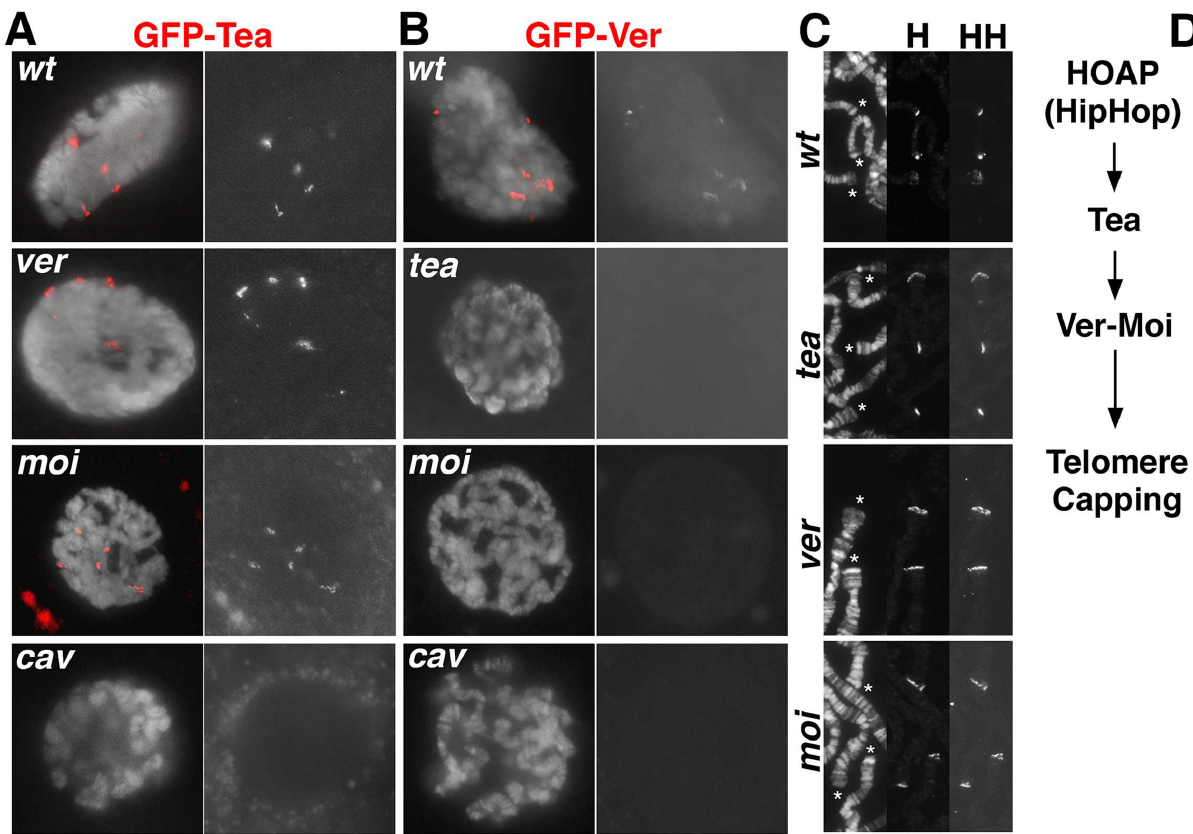
Fig 2. Genetic control of capping protein localization on polytene chromosomes. The localization of GFP-Tea ( A ) and GFP-Ver ( B ) under different genetic backgrounds was monitored as live GFP fluorescence.At least 50 nuclei were examinedfor each genotype and all nuclei showed a “present” or “absent” pattern of GFP fluorescence similar to the ones chosen for the Figure. The localizationof HOAP and HipHop under similar genetic backgrounds was monitored by antibody staining ( C ). For A and B , genotypes are indicatedat the top left of the images. For C , genotypesare indicatedto the left of the images. In A and B , the left panel displaysmerged images of GFP signal in red and DNA signal in white, and the right panel displaysimages with GFP signals in white. In C , the left panel displays polytene chromosomes in white with telomeres indicatedwith asterisks. The middle panel displays images with anti-HOAP ( H ) signalin white. The right panel displays anti-HipHop ( HH ) signals. D . HOAP (and likely HipHop),Tea, and the Moi-Ver complex are components of a linear pathway for capping protein loading. Bindingof capping proteins ultimately controls the accessibility to chromosome ends as suggestedby the ExoI protection experiments shown in Fig 4. Genotype of mutants: ver S147910 /Df ; moi CB02140 /Df ; tea 1755 /Df ; cav 1 /Df ( Df is a chromosomal deficiency of the corresponding mutant